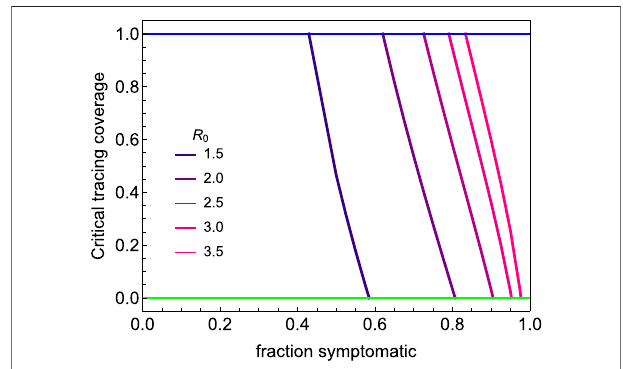
FIGURE 5 | The critical tracing coverage for varying percentages of symptomatic infections and values of the basic reproduction number R 0 between 1.5 and 3.5. If the critical tracing coverage is above the line, the outbreak can be controlled. However, if the coverage reaches the blue line,controlislost.Ifmorethan20%ofcasesescape diagnosis,becausethey are asymptomatic or have only mild symptoms, for R 0 (cid:2) 2 . 5 the outbreak is not controllable even with our optimistic baseline values for the intervention